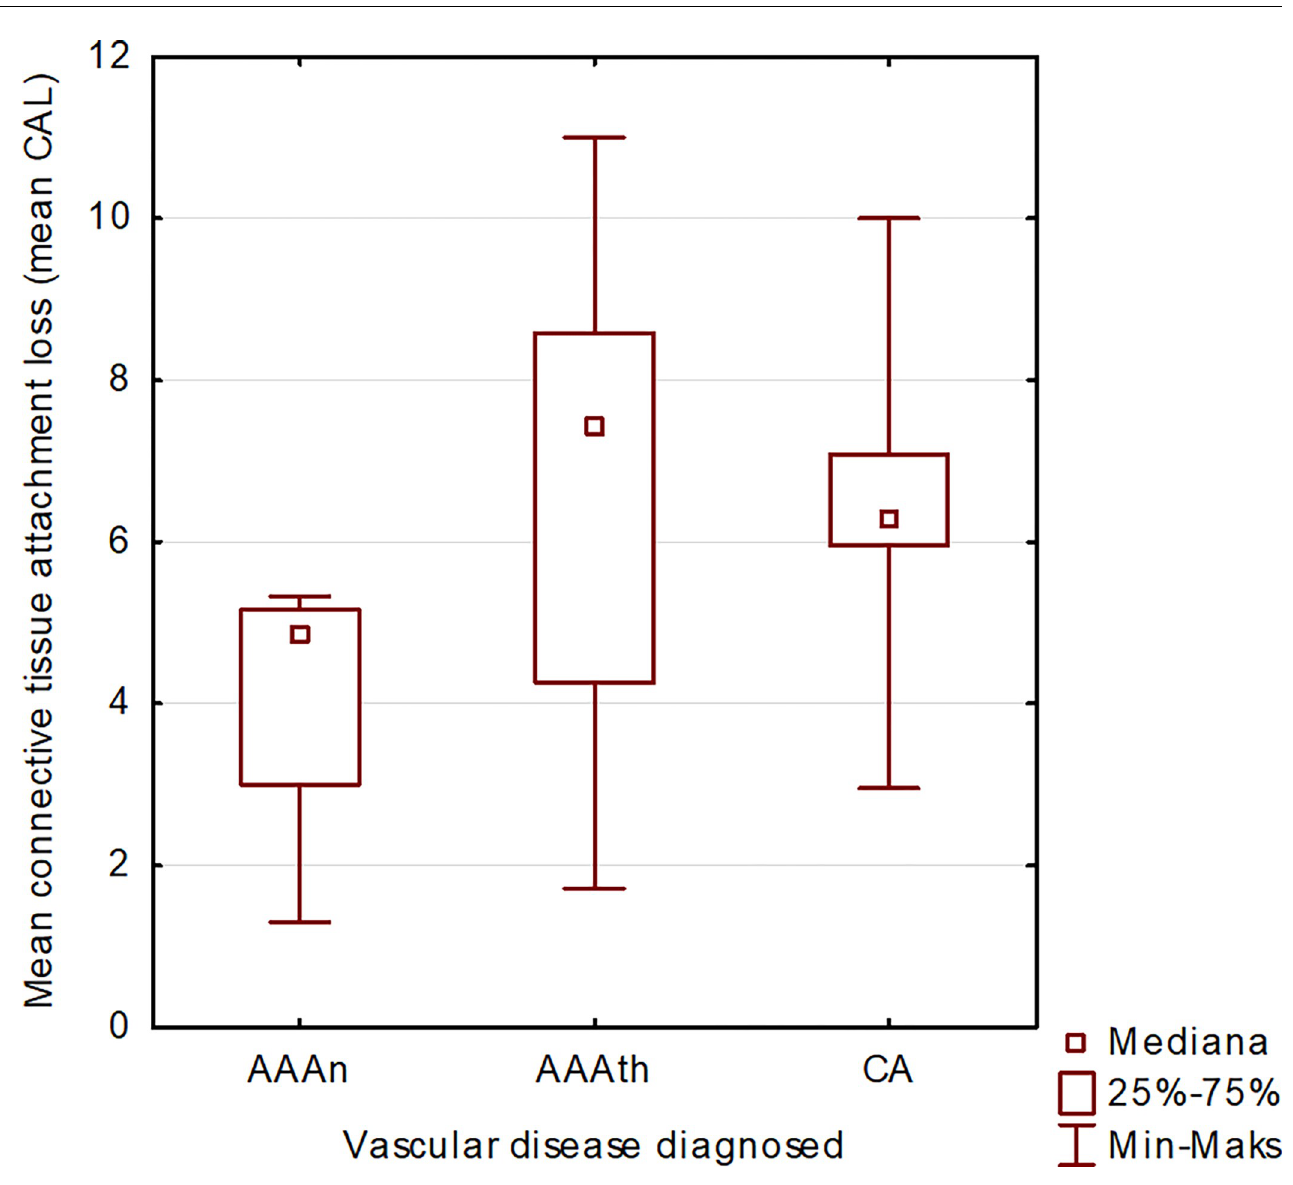
Fig 3. Mean PPD in correlation with